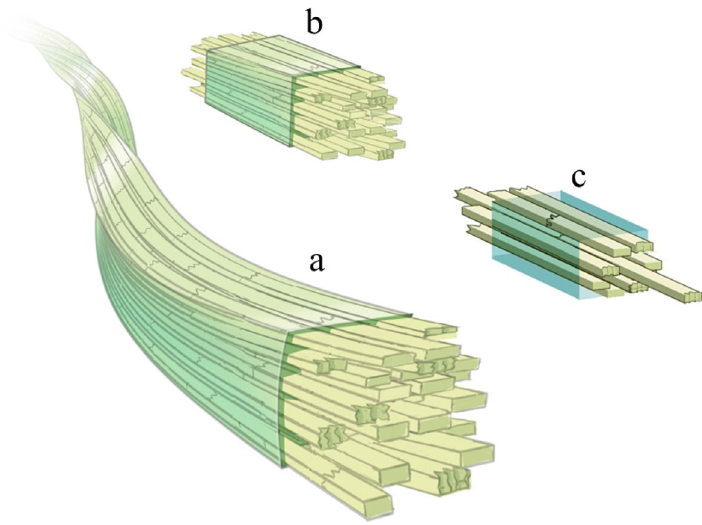
Figure 6. Finger-jointing structures for lengthening cellulose microfibrils. ( a ) Polysaccharide chains in cellulose microfibrils are not the seamlessly long length of polymers, but relatively short (10 s to 100 s of nm in length), and each of the short chains is jointed in a finger-jointing manner. Finger-jointing is weaker but flexible compared to the packed (vertical) structures. Under tough conditions, such as in saturated water vapor at higher temperature/pressure, cellulose microfibrils unzipped into short blocks starting at the finger-jointing boundaries. ( b ) Once the microfibril unzipped into short blocks, ( c ) polysaccharide chains situated at the outmost layers of the block detached from the main body as a thinner